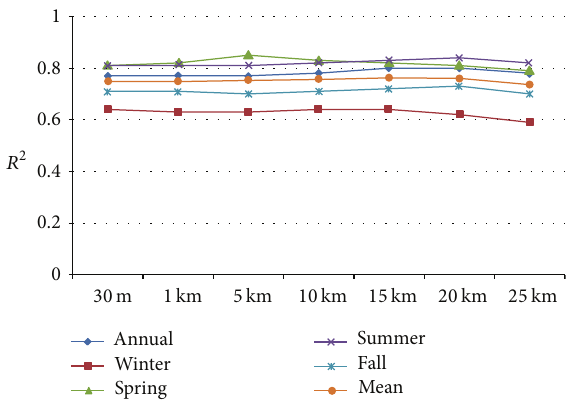
Figure 6: Coefficient of determination (𝑟 2 ) derived by GWR model against different smoothing window size of mean altitude values.